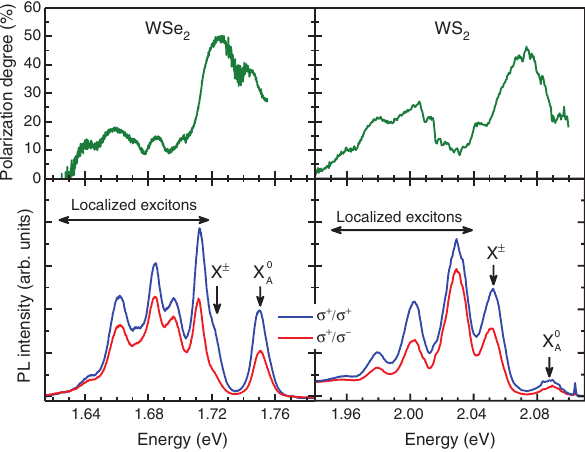
Figure 10: Optical pumping experiment performed when using a σ + polarized optical excitation and detecting the circularly polarized photoluminescence of monolayers of WSe (right